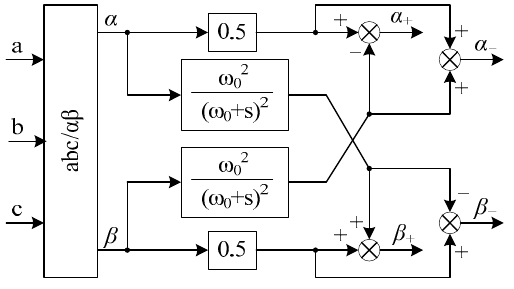
Figure 4. Block diagram of sequence component extraction.